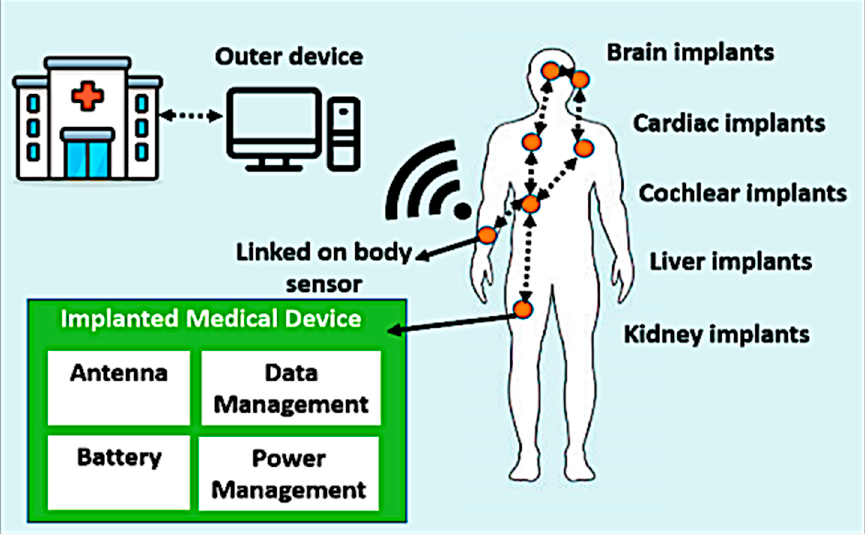
Figure 1. Implanted WBAN for healthcare monitoring.